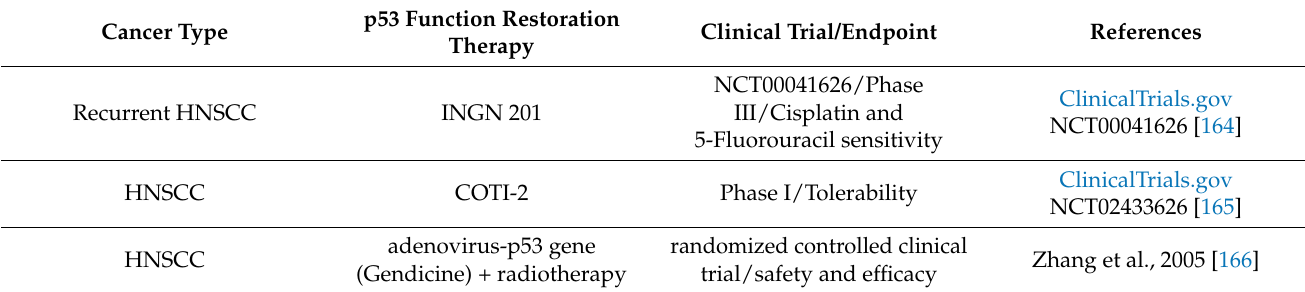
Table 4. Clinical trials based on p53 restoration therapy for